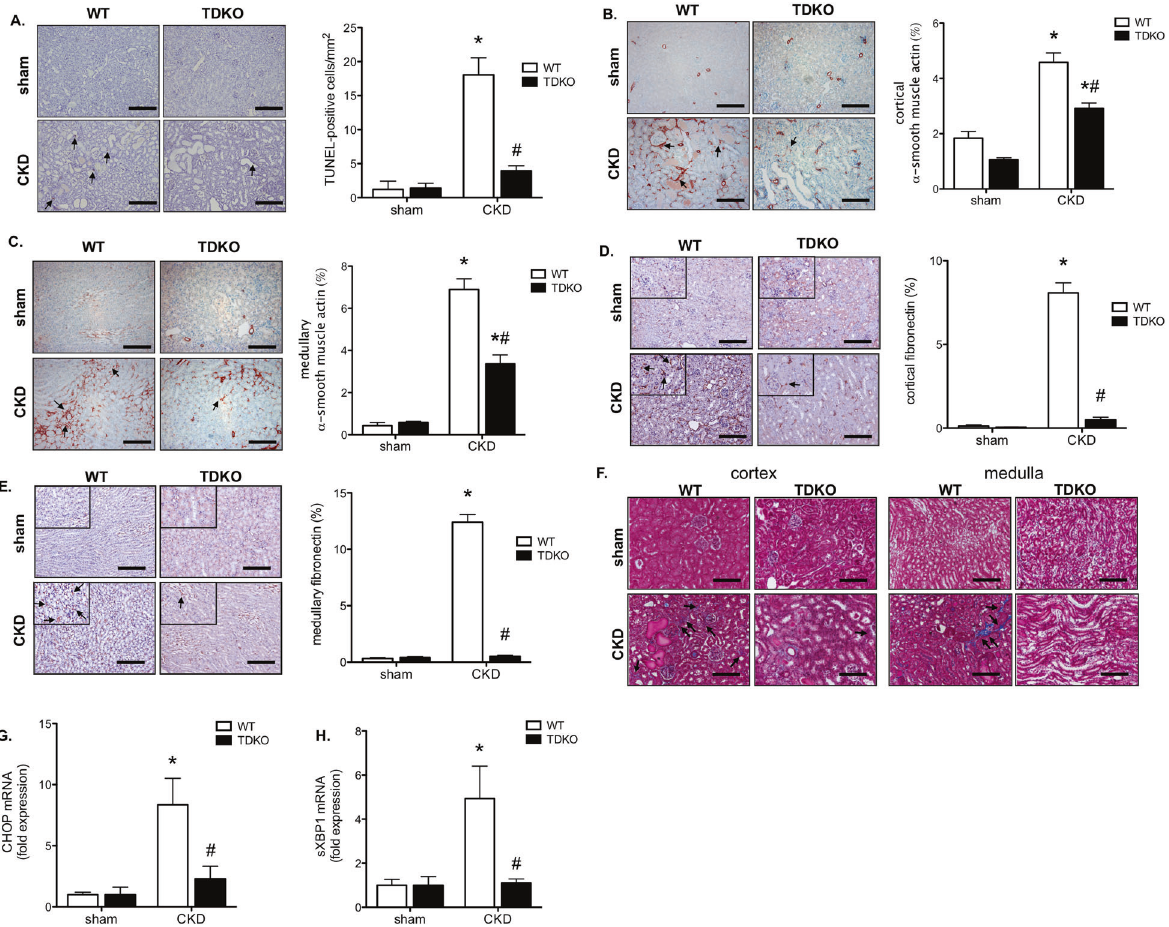
Fig. 4 TDAG51 knock out prevents apoptosis and reduces renal interstitial fi brosis in chronic kidney disease. A Kidneys were stained with TUNEL to measure apoptotic cell death (arrows). WT mice with CKD demonstrated increased apoptosis in the cortex, primarily the proximal tubules, of the kidney. TDKO mice with CKD did not experience increased apoptosis. Kidneys were examined for markers of renal interstitial fi brosis. α -smooth muscle actin (SMA) is increased in the cortex ( B ) and medulla ( C ) of WT mice with CKD, when compared with sham WT mice. TDKO mice with CKD also demonstrated increased fi brosis in the kidney, though levels of α -SMA were signi fi cantly lower than WT mice. Fibronectin levels were increased in the ( D ) cortex and ( E ) medulla of WT mice with CKD; fi bronectin expression was inhibited in TDKO mice with CKD. F Masson Trichrome stain reveals less collagen deposition (blue; arrows) in TDKO mice with CKD compared with WT mice with CKD. Renal tissue demonstrated increased CHOP mRNA ( G ) and sXBP1 ( H ) in WT mice with CKD, but not TDKO mice with CKD. Bar = 200 μ m. * P < 0.05 vs sham; #, P < 0.05 vs